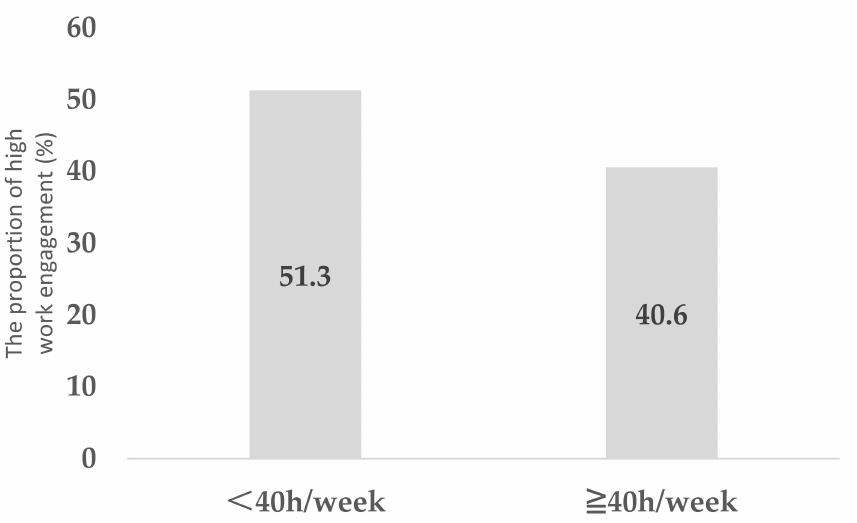
Figure 3. The association between working hours and higher work engagement among employees working from